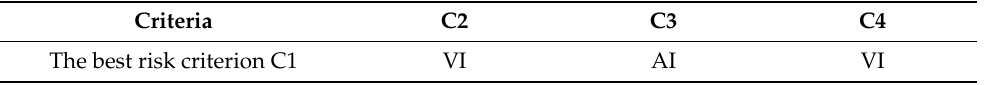
Table 2. The linguistic terms for fuzzy preferences of the best risk criterion over other risk criteria. Criteria The best risk criterion C1